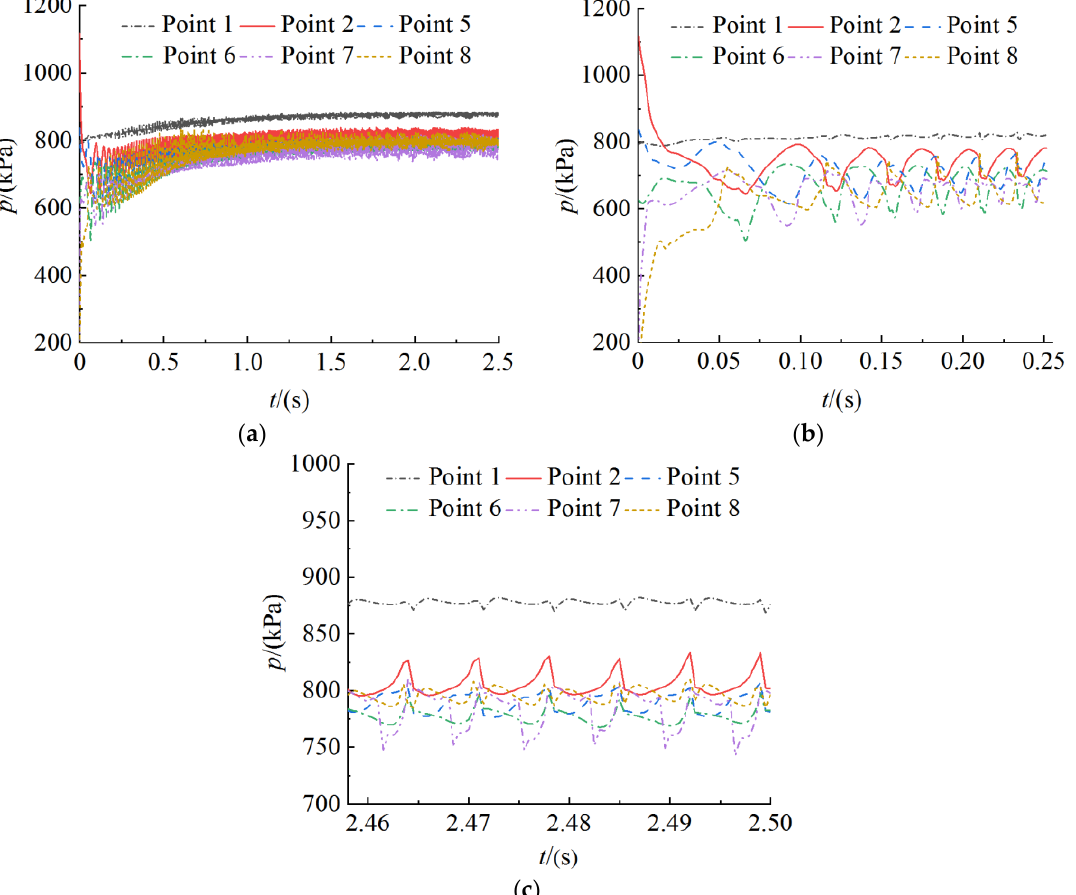
Figure 13. Time domain of pressure fluctuation at volute circumferential location. ( a ) t = 0~2.5 s; ( b ) t = 0~0.255 s; ( c ) t = 2.458~2.5 s.